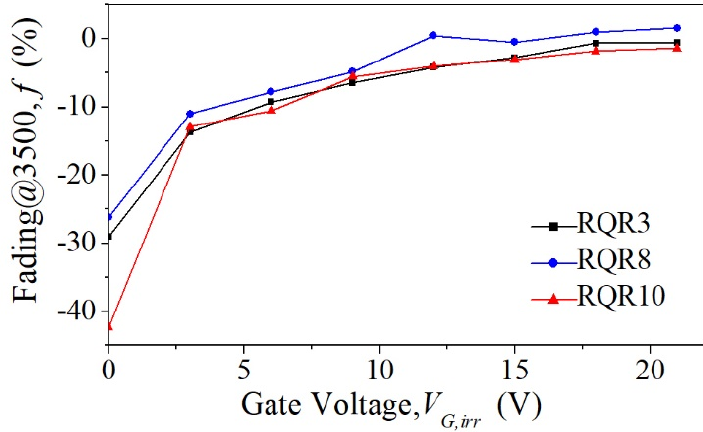
Figure 10. Fading at 3500 h versus gate voltage during irradiation .